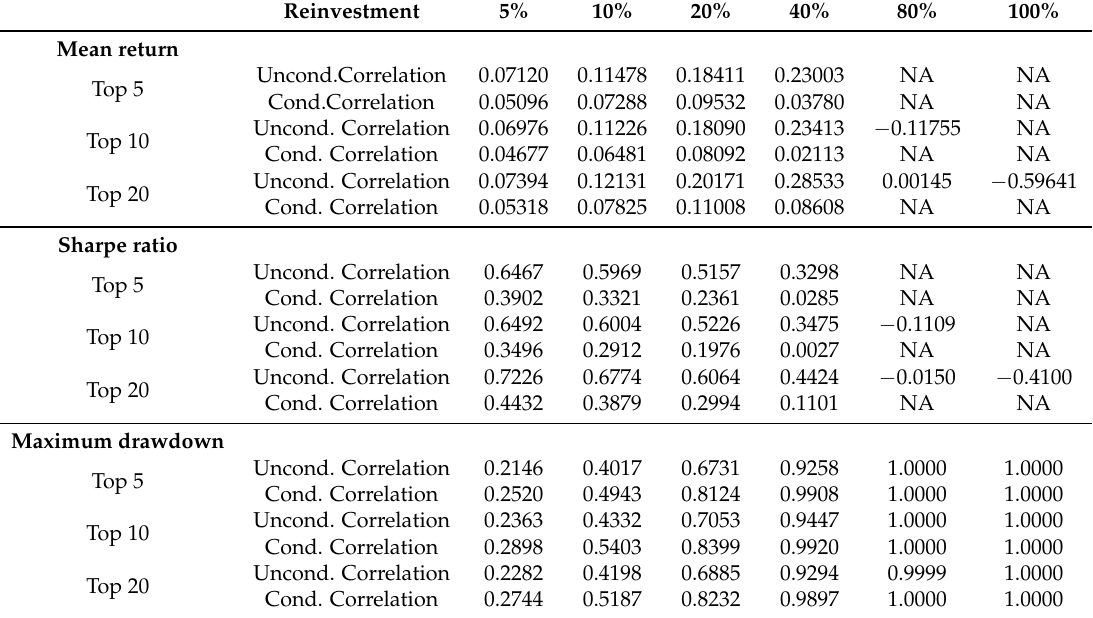
Table 6. Annualized mean return, Sharpe ratio, and maximum drawdown before transaction costs for a varying number of top stocks, the amount of reinvestment, and the correlation filter from